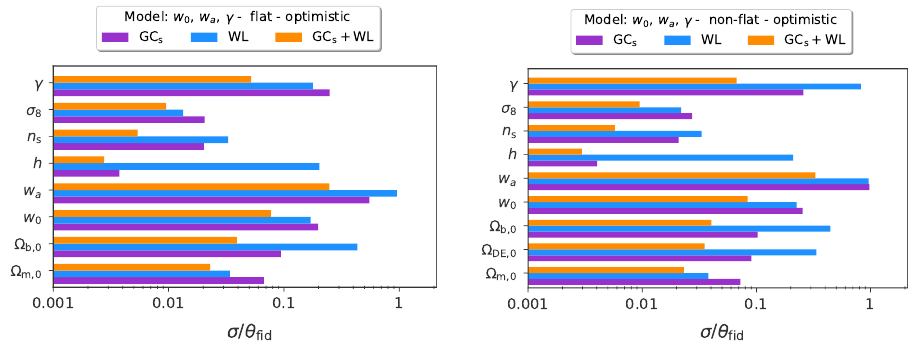
Figure 3. Relative errors on cosmological parameters and on the γ controlling the deviation from the standard growth. The results shown here include spectroscopic galaxy clustering (purple), weak lensing (blue) and their combination (orange). This figure is obtained in